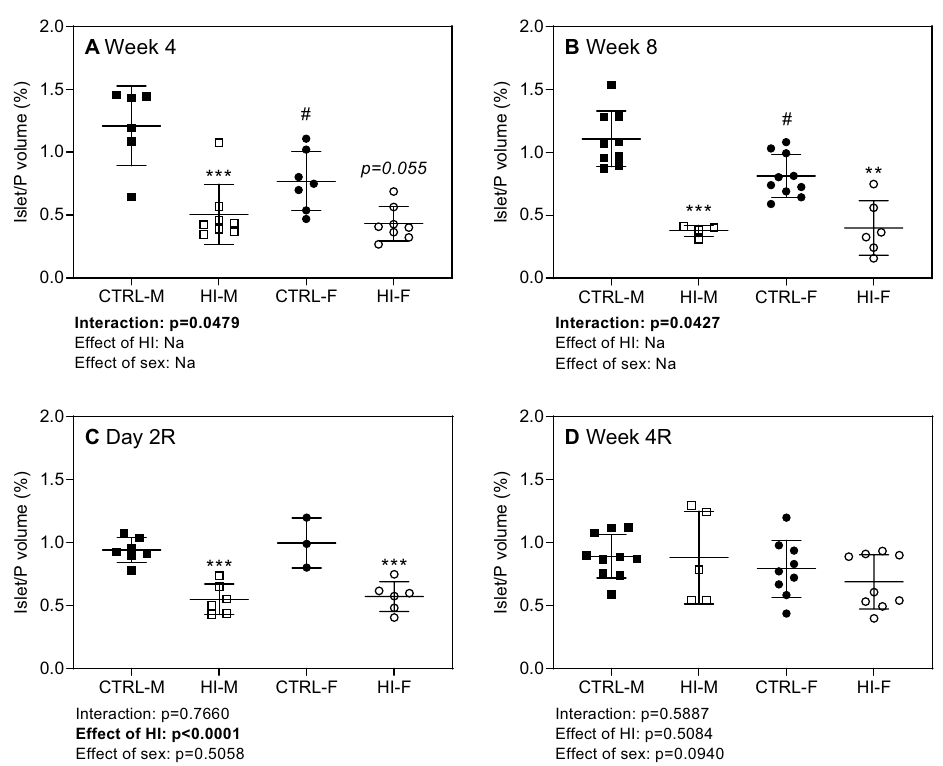
Figure 5. Relative islet to pancreas volume, individual (symbols) and means ± SDs. ( A ) Week 4: CTRL-M, n = 6; HI-M, n = 8; CTRL-F, n = 7; HI-F, n = 8. ( B ) Week 8: CTRL-M, n = 9; HI-M, n = 4; CTRL-F, n = 10; HI-F, n = 6. ( C ) Day 2R: CTRL-M, n = 7; HI-M, n = 6; CTRL-F, n = 3; HI-F, n = 6. ( D ) Week 4R: CTRL-M, n = 10; HI-M, n = 5; CTRL-F, n = 9; HI-F, n = 9. ** p < 0.01, *** p < 0.001 versus control group for the same sex, # p < 0.05